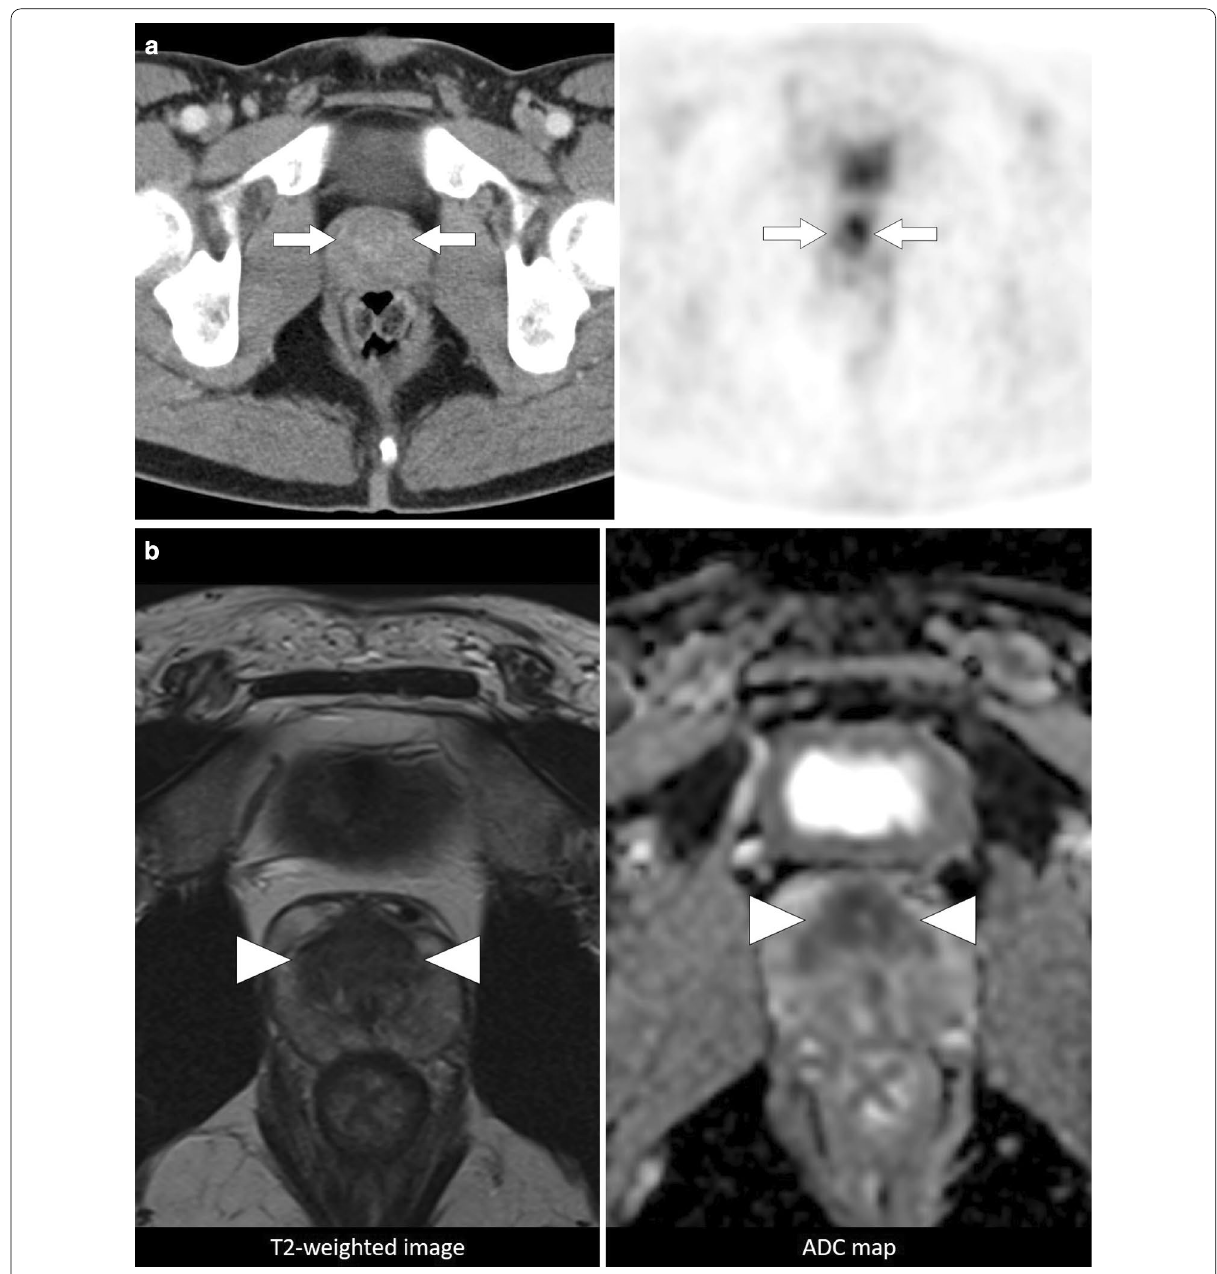
Fig. 3 IgG4-related prostatitis. A 32-year-old man with well-established IgG4-RD underwent PET/CT for evaluation of disease activity. a Axial plane PET/CT images revealed an FDG-avid nodular lesion (arrows) in the prostate gland. Because of the patient’s medical history, prostatic involvement of IgG4-RD was considered primarily. Patient declined histopathological evaluation, and preferred close follow-up. b Follow-up multiparametric prostate MRI 4 years after the initial PET/CT examination showed no significant change in size in the 4-year interval. Axial T2-weighted image and ADC map (b 1000 s/mm 2 ; 1.5 T), respectively, demonstrate T2-hypointense lesion with low ADC values =